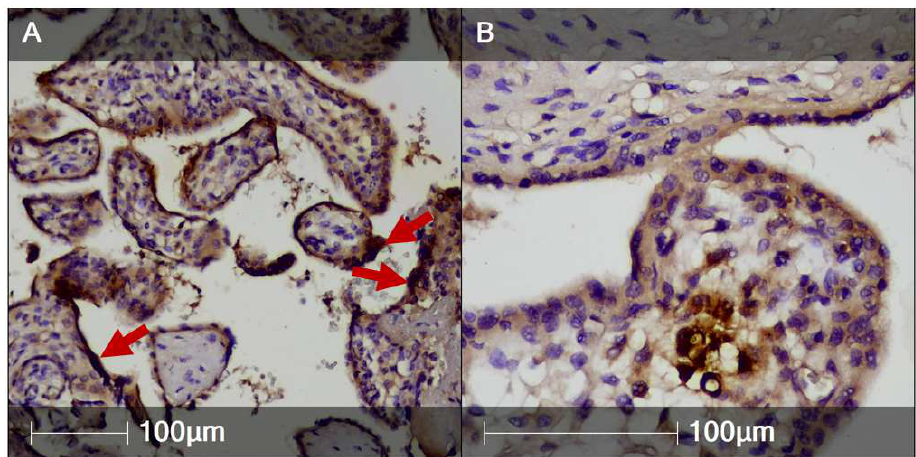
Figure 5. SARS-CoV-2 nucleocapsid protein in the inflamed placental tissue (IHC) . Areas of the placenta positively stained for SARS-CoV-2 nucleocapsid protein. ( A ) Syncytiotrophoblast (red arrows); ( B ) Villous stromal cells.